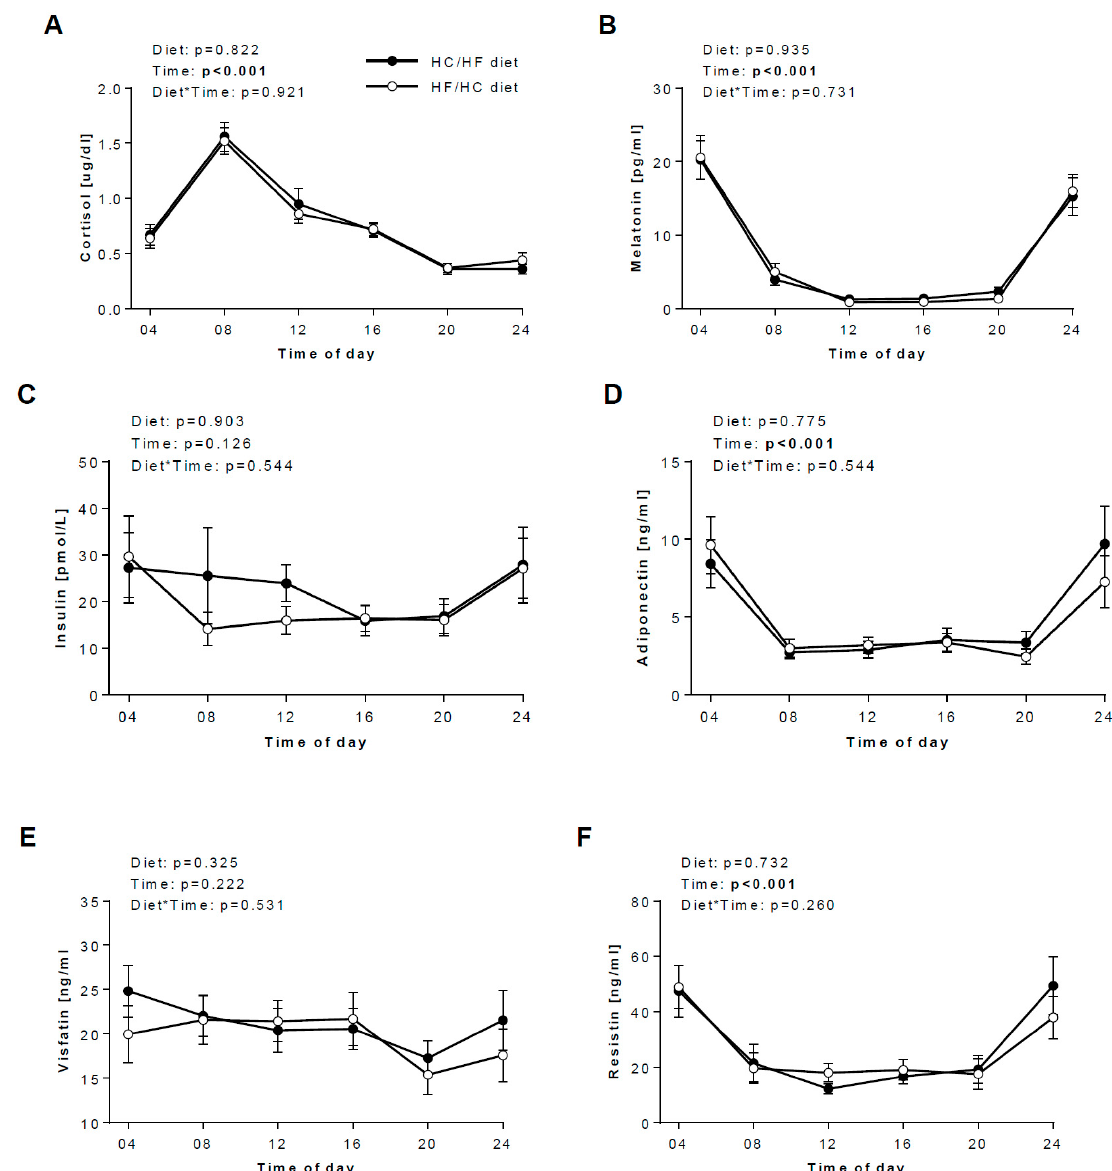
Figure 2. Salivary metabolic biomarkers in response to the HC / HF and HF / HC diet. E ff ects of the HC / HF diet (black circles) and the HF / HC diet (open circles) on 24-h concentrations of ( A ) cortisol ( n = 24), ( B ) melatonin ( n = 20), ( C ) insulin ( n = 15), ( D ) adiponectin ( n = 20), ( E ) visfatin ( n = 22) and ( F ) resistin ( n = 23). Repeated measures two-way ANOVA was applied to determine the e ff ect of diet, time and diet*time interaction. Data are means ± SEM. HC / HF diet, isocaloric high-carb meals until 13:30 and isocaloric high-fat meals between 16:30 and 22:00; HF / HC diet, reversed order of meal sequence.